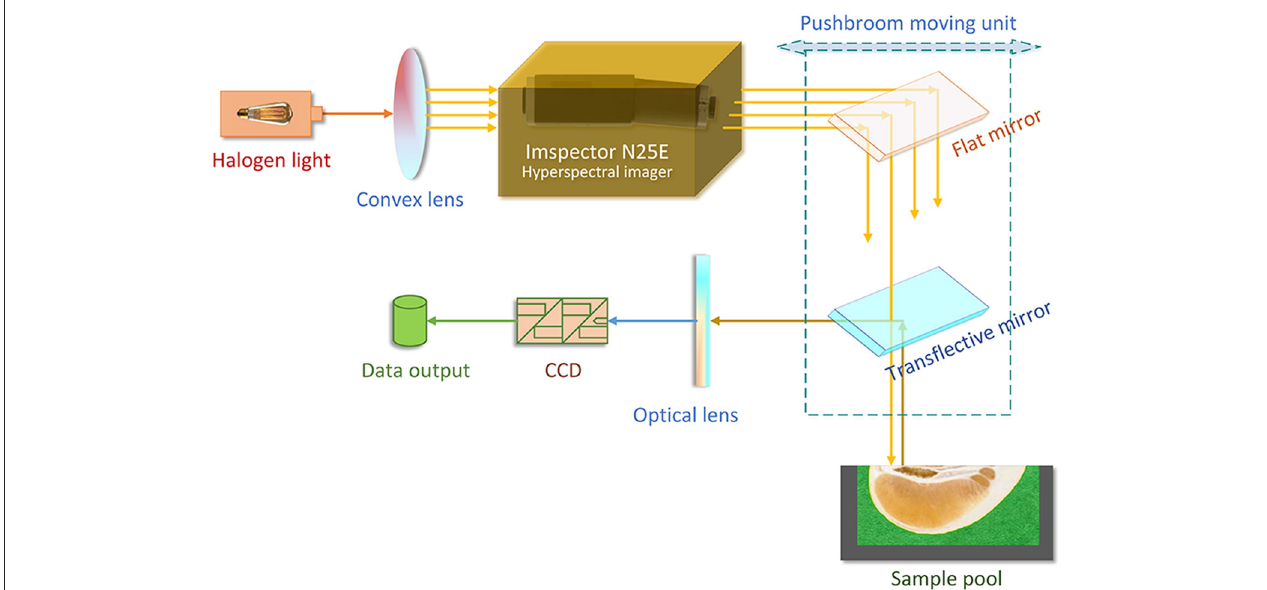
FIGURE 1 | The construction of the NIRHI optical system.